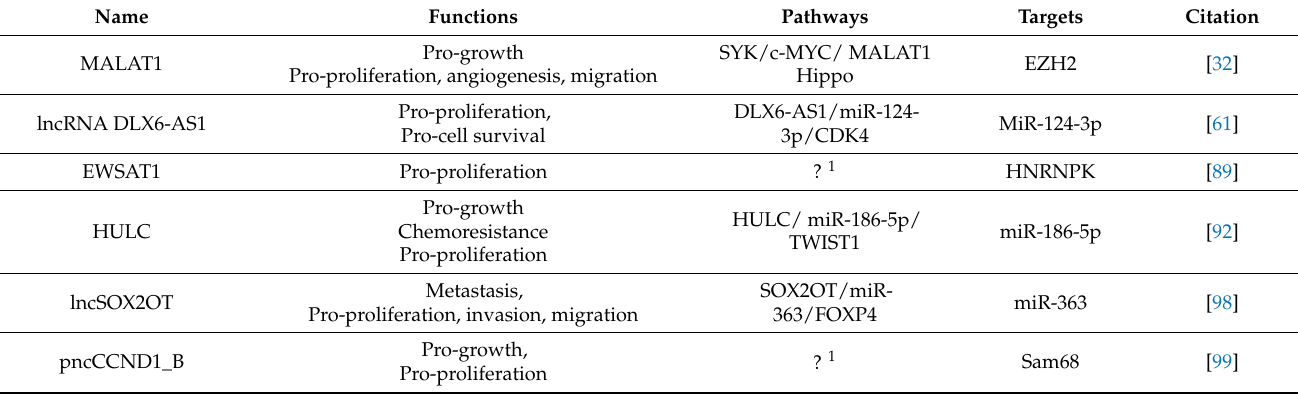
Table 3. LncRNA in Ewing’s